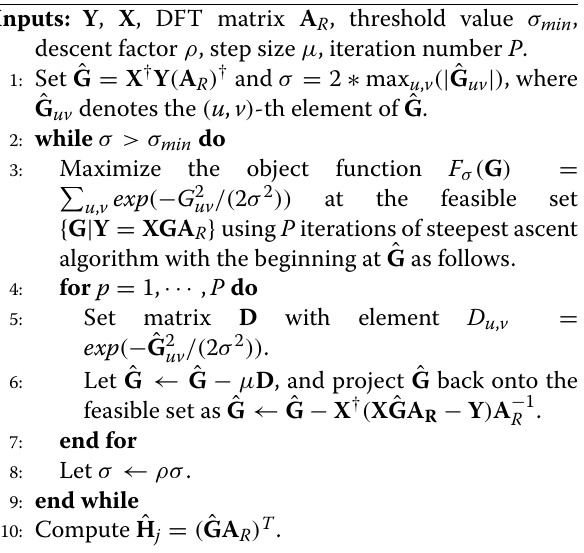
Algorithm 1 2D-SL0-CE channel estimation method